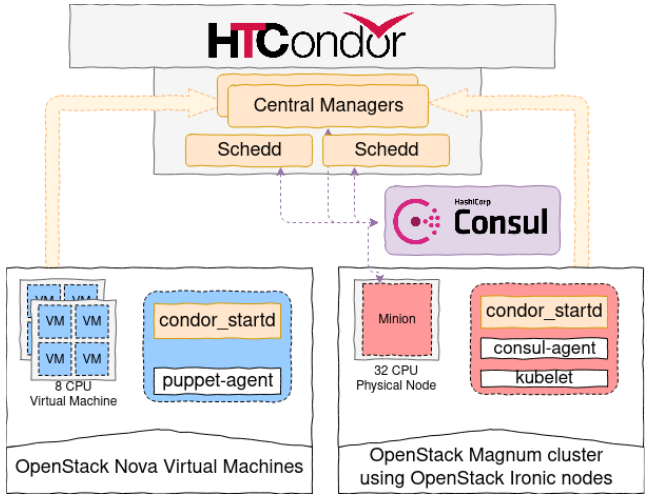
Figure 1. Overview of the resource configuration used in the prototype HTCondor